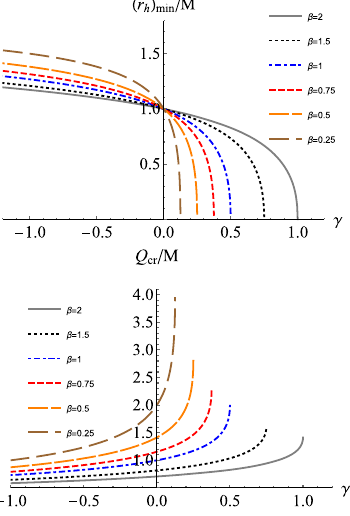
Fig. 3 Critic values of BH charge and minimal radius of the event horizon, as a function of the parameter γ for different values of the parameter β